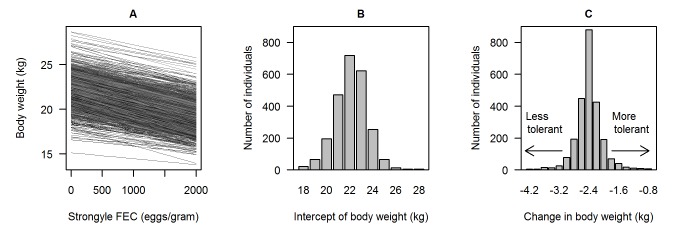
Significant individual-level variation in tolerance of gastrointestinal nematodes by the Soay sheep.All plots show results of the best-fitting random regression model of tolerance, shown in full in Table 1A. (A) Predicted slopes of the decline in body weight with increasing strongyle FEC for each of the 2,934 individuals in our analyses. Model predictions used for plotting Figure 2A are given in Table S5. Because of the high density of crossing slopes in (A), we also provide (B) a histogram of the distribution of the estimated individual intercepts of body weight (i.e., body weight where FEC = 0) and (C) a histogram of the estimated slopes of individual changes in body weight from 0 to 2,000 eggs/gram of FEC. The most tolerant hosts lose the least weight; the least tolerant lose the most weight. FECs of up to 2,000 represent >98% of the range of parasite burdens experienced by the population. Model estimates used to generate histograms are given in Table S6.